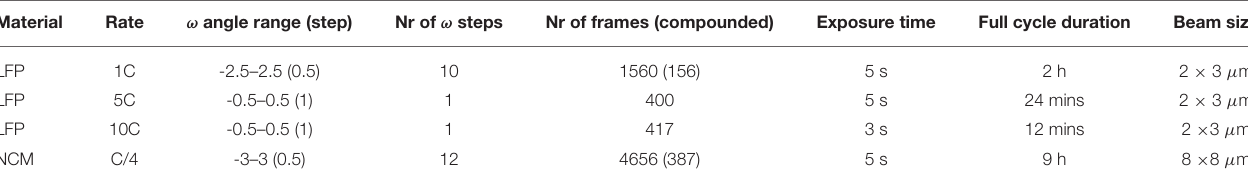
TABLE 1 | Experiment execution